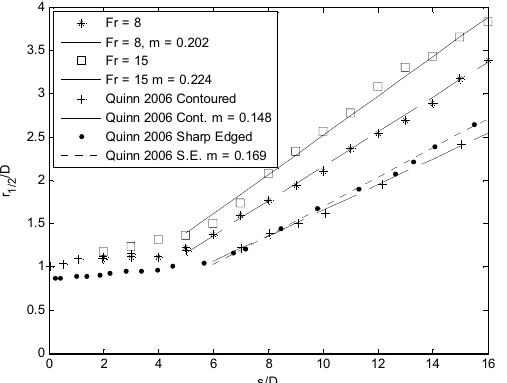
Figure 3. Widening of INBJs with Re = 1000, θ = 65°, Fr = 8 (asterisks) and 15 (squares) and of two simple jets (Quinn 2006 [15]; sharp-edged orifice: black dots; contoured orifice: black crosses); s/D is the abscissa measured streamwise along the axis from the origin; the straight lines are the best fit ones in a least mean square sense; the coefficient m in the legend is the inclination of the straight